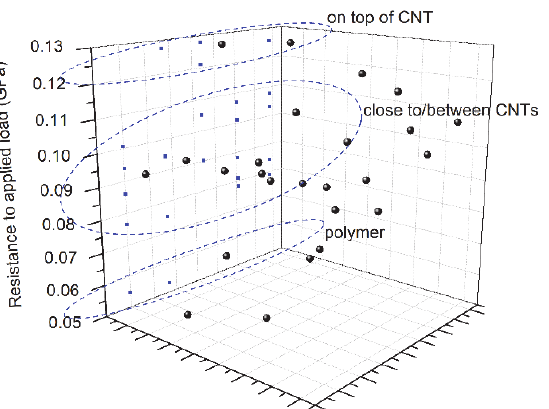
Figure 10: Resistance to applied load mapping, at 300nm of displacement for a grid of 70  70 μ m 2 for MWCNT/PP 2 wt% specimen.